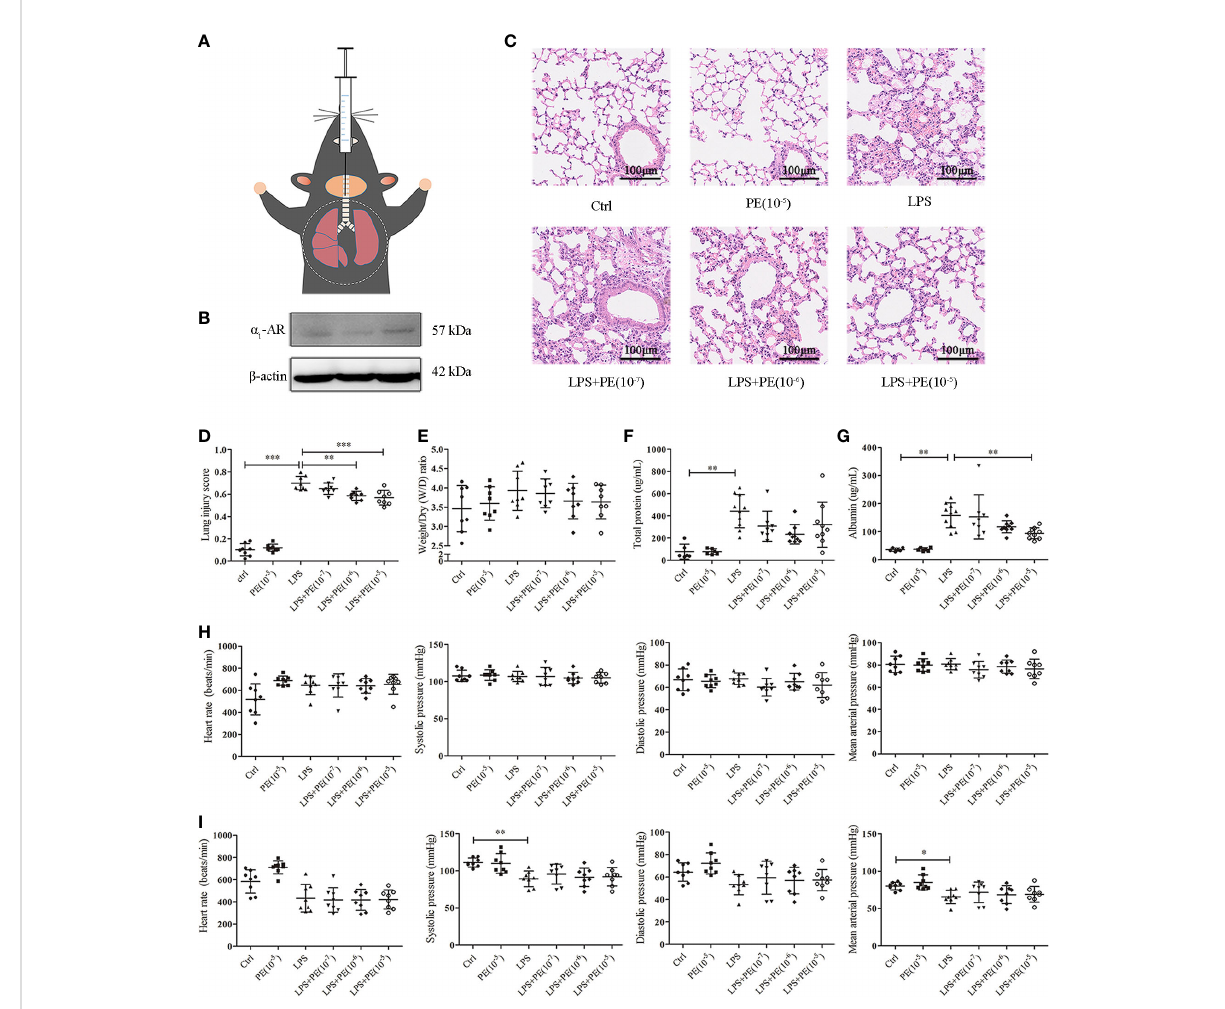
FIGURE 1 Phenylephrine (PE) attenuated lung pathological injury and alveolar capillary barrier disruption without in fl uencing the cardiovascular haemodynamics of ARDS mice. Mice were given an intratracheal instillation of 2 mg/kg lipopolysaccharide (LPS) to induce ARDS, and PE was injected into trachea 20 min before LPS stimulation. Lung tissues and bronchoalveolar lavage fl uid (BALF) were collected 24 h after LPS stimulation. (A) Method for intratracheal instillation of LPS or PE in mice. (B) Expression of a 1 -AR in lung tissues of mice. (C) Haematoxylin and eosin staining of lung slices. Scale bar = 100 m M. (D) Histology scores of lungs were judged according to guidelines of the American Thoracic Society. (E) Wet/dry weight ratio of lung tissues. (F) Levels of total protein in BALF. (G) Levels of albumin in BALF. (H) Heart rate (HR), systolic blood pressure (SP), diastolic blood pressure (DP), and mean artery pressure (MAP) of mice were monitored before establishing ARDS model. (I) HR, SP, DP, and MAP of mice were monitored 24 h after establishing ARDS model. Data are represented as the mean ± SD, n = 6 – 10 per group. * p < 0.05, ** p < 0.01, *** p <